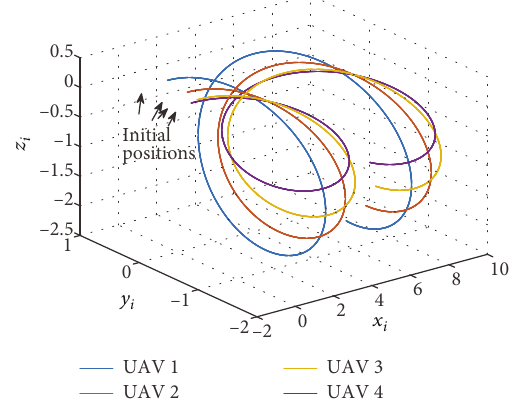
Figure 5: State trajectories of formation errors.